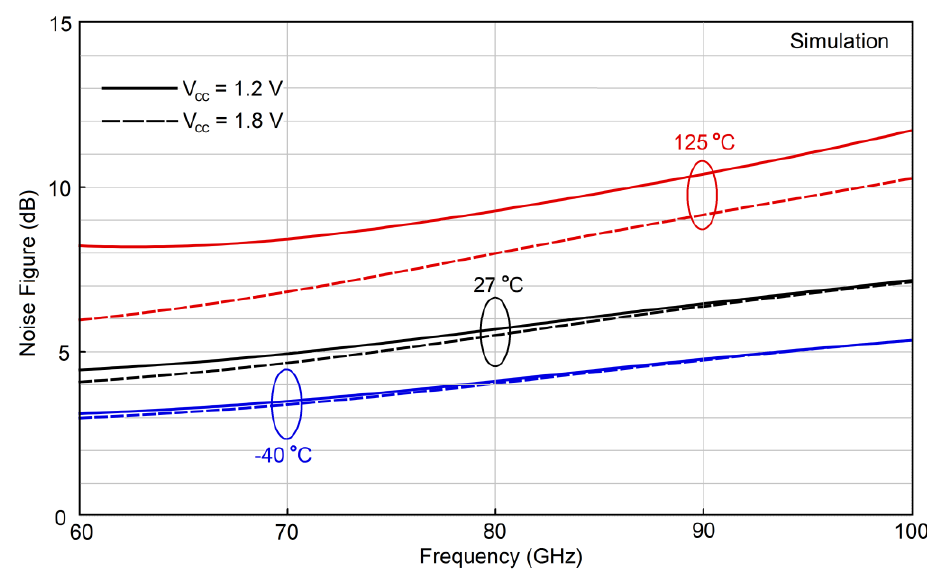
Fig. 4. Simulated NF versus frequency characteristics at different temperatures and supply voltages.